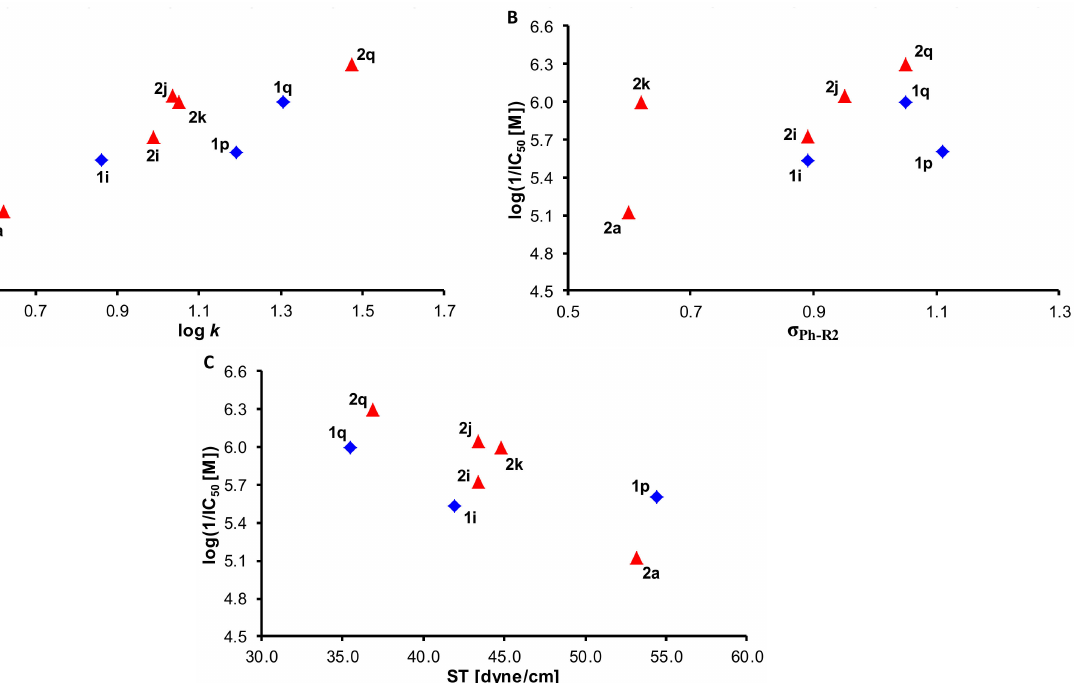
Figure 4. Relationships between in vitro cell viability on human monocytic leukemia cells (THP- 1) in serum-free medium log(1/IC 50 [M]) and lipophilicity expressed as log k ( A ), electronic σ parameters of ring-substituted anilide ring ( B ) and surface tension ( C ) of studied compounds (blue rhombuses = series 1 , red triangles = series 2